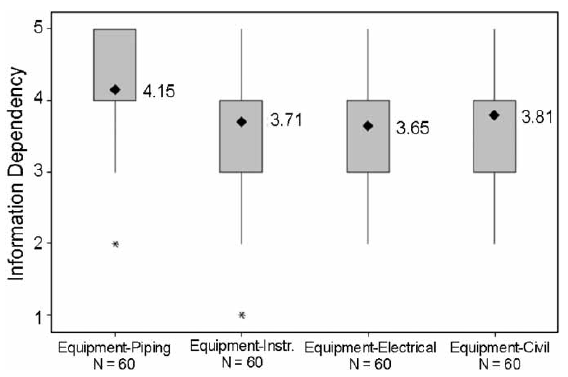
Fig. 3. Information dependencies assessed by industrial